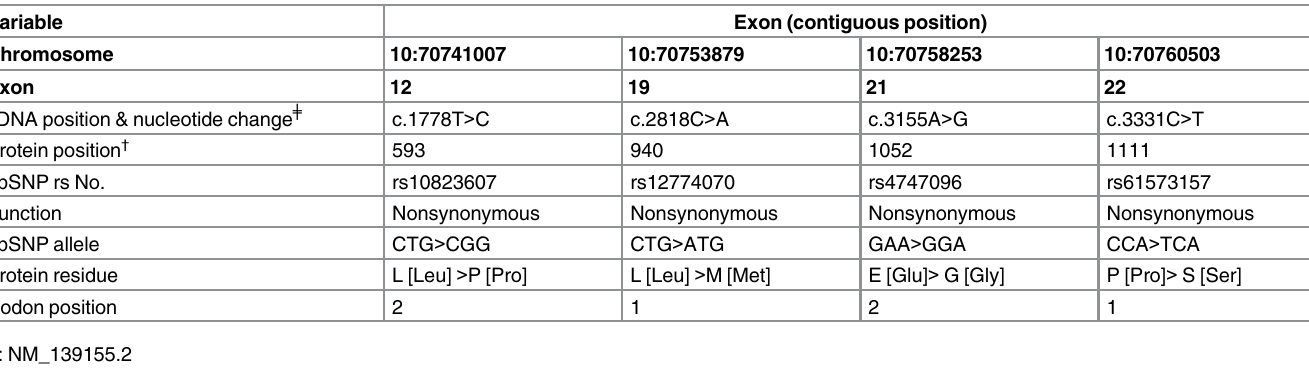
Table 1. ADAMTS14 gene polymorphisms assessed in this